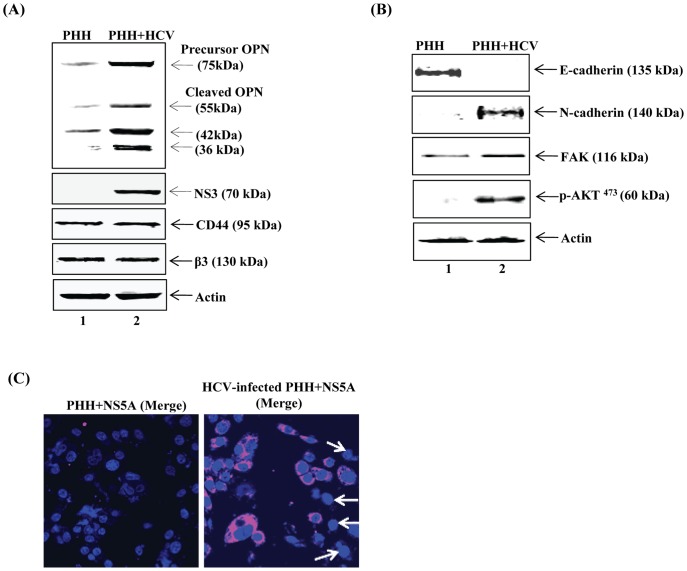

HCV induces OPN and signaling cascade in primary human hepatocytes
                            (PHH).
(A, B) Equal amounts of cellular lysates from PHH (lane 1) and
                            HCV-infected PHH (lane 2) were subjected to western blot analysis using
                            anti-OPN, anti-CD44, anti-β3, anti-E-cadherin, anti-N-cadherin,
                            anti-FAK, and anti-pAkt (Ser 473). HCV NS3 represents HCV
                            infection and actin was used as protein loading control. (C)
                            Immunofluorescence microscopy of HCV-infected PHH. HCV-infected PHH was
                            incubated with HCV NS5A antibody for 1 h at RT followed by 1 h
                            incubation with secondary HCV NS5A antibody (anti-rabbit Alexa Fluor
                            546) as describe in Materials and Methods. The magenta color indicates
                            expression of HCV NS5A around the nucleus. Arrow indicates few
                            uninfected cells. DAPI was used as a nuclear stain in blue color. Scale
                            bar 10 µM. The results shown are the representative of three
                            independent experiments.